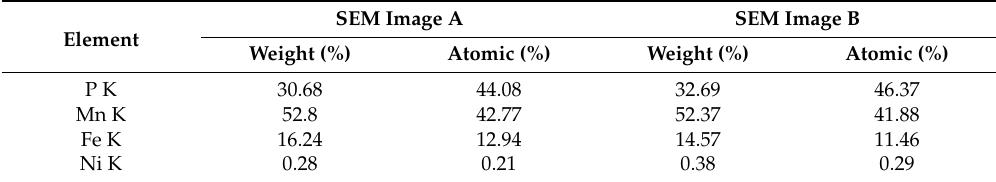
Table 6. The chemical composition of the A (Ni_Ref) and B (Ni_0.15) samples based on EDX